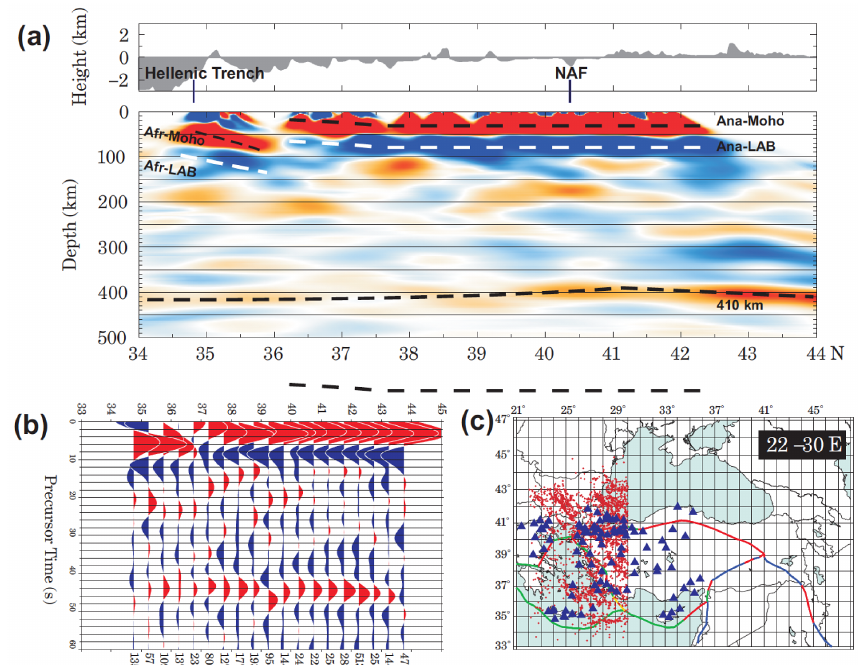
Figure 5. Display of S-receiver functions along a north–south profile between 22 and 30 ◦ E (Aegean and western Anatolia). Topography is displayed on top of the figure. (a) CCP stack (depth–transformation). (b) Time-domain stack for same profile as in (a) . A slowness of 6.4sdegree − 1 is used for the moveout correction. The binning is determined by the location of piercing points at 200km depth. The numbers below the bottom y axis show how many traces have contributed to each trace. (c) Blue triangles are stations which contributed data to the profile. Red dots are locations of S-to-P piercing points at 200km